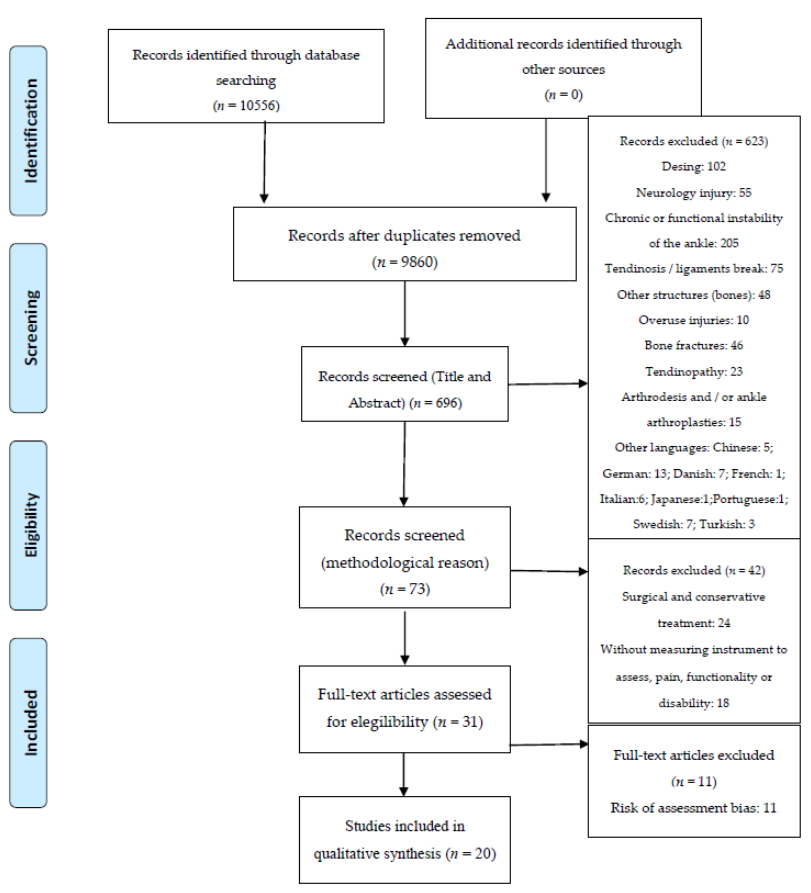
Figure 1. Preferred Reporting Items for Systematic Reviews and Meta-Analyses (PRISMA) Flow Diagram.